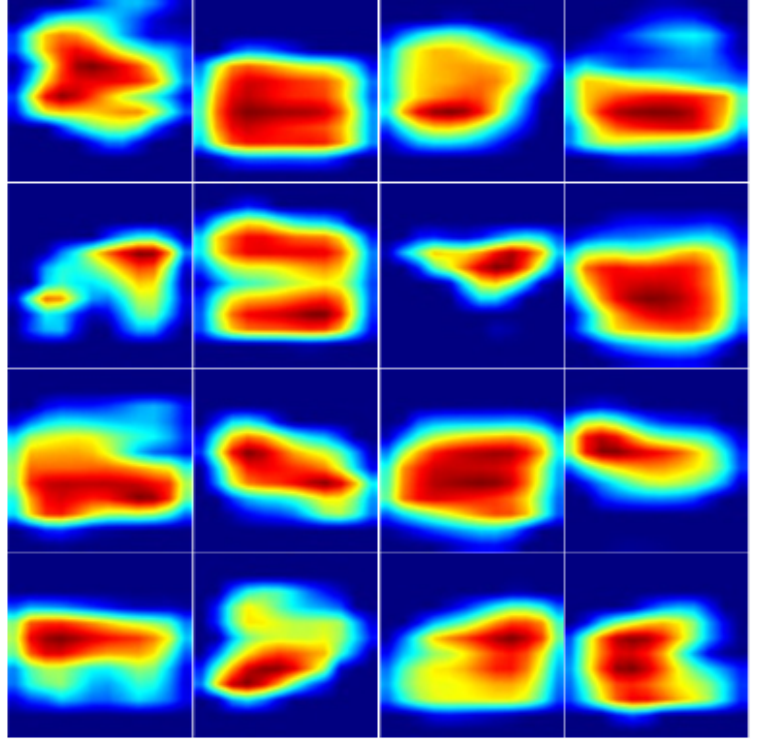
Figure 9. Visualizations of deep representations corresponding to each sample in Figure